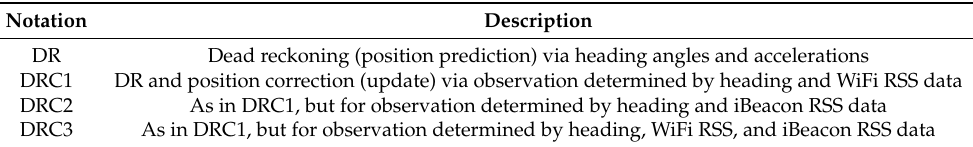
Table 2. Localization Schemes for Experimental Tests.